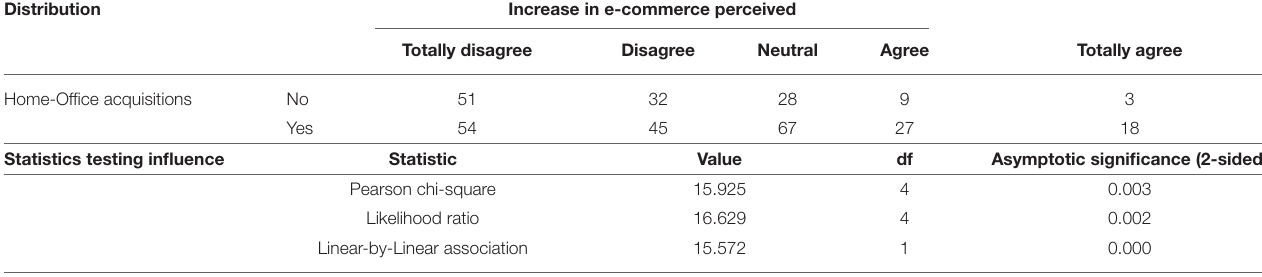
TABLE 2 | Descriptive statics purchases.